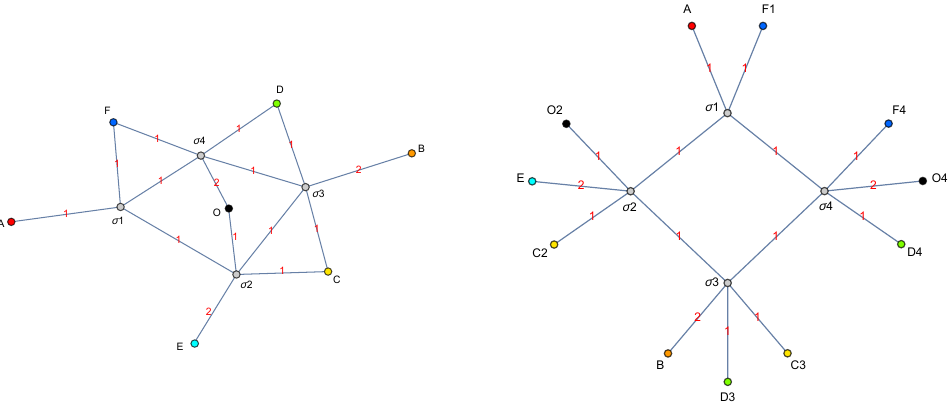
Figure 13. Alternative graph realizations of one of the extreme rays of the HEC 6 . Notice that one of these realizations is a tree graph.